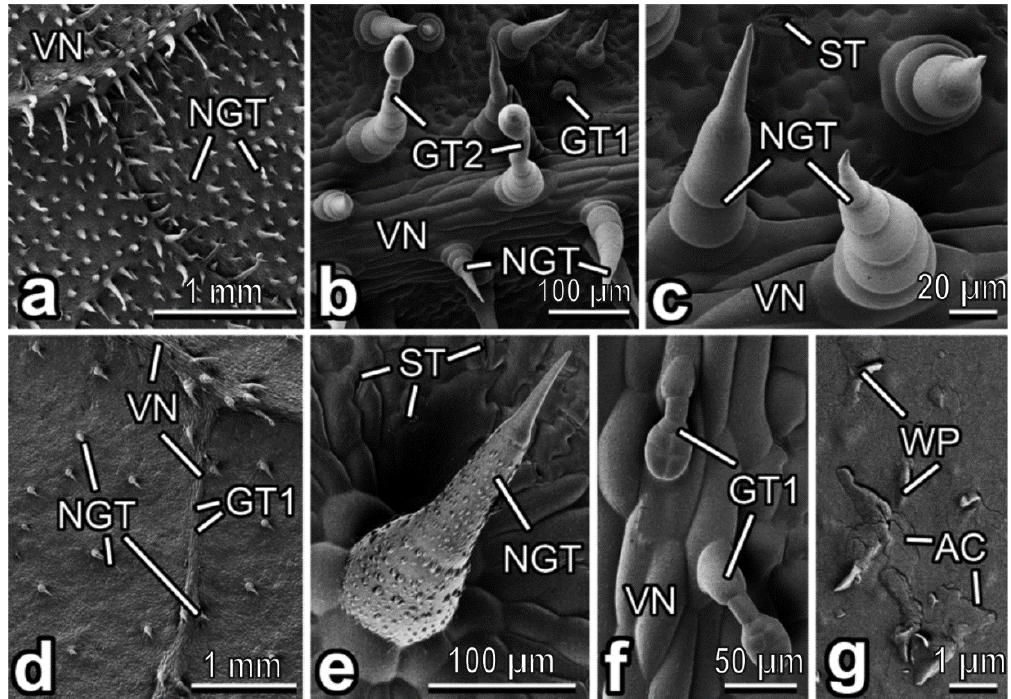
Figure 6. Abaxial leaf side of Lagenaria siceraria ( a – c ) and Luffa aegyptiaca ( d – g ), cryo-SEM. ( a , d ) General view of the surface. ( b ) Leaf surface with the vein. ( c , e ) Non-glandular trichome(s). ( f ) Glandular (short-stalked) trichomes. ( g ) Epicuticular wax coverage. AC; artificial cracks in the smooth epicuticular wax layer; GT1: clavate short-stalked glandular trichome; GT2: capitate long-stalked glandular trichome; NGT: non-glandular trichome; ST: stoma; VN: vein; WP: epicuticular wax